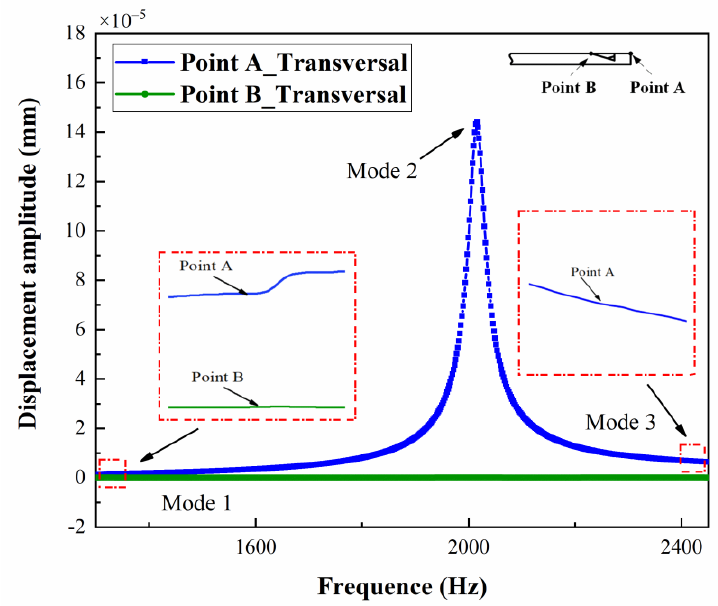
Figure 6. The transversal amplitudes of the microstirrer at the stirrer tip and beam.